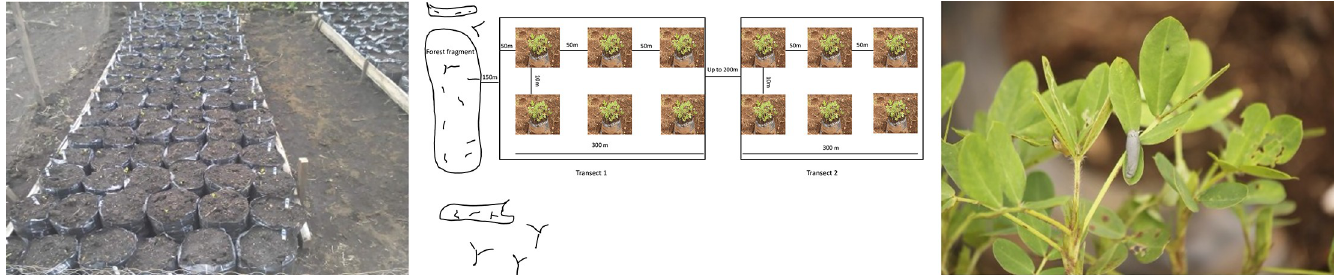
Fig 2. Experimental set-up. (A) seeds of groundnuts and bambara nuts planted into polypots. (B) Experimental set up in farmlands; six crop plants were placed in each transect (i.e., three replications for each crop species). (C) Mimics placed on crop plant. https://doi.org/10.1371/journal.pone.0255638.g002 sections. In total, six crop plants (i.e., three replications for each crop species) were placed in each transect (Fig 2B). To estimate bird predation rates, we used plasticine, a non-toxic putty-like modelling mate- rial (Newplast, UK). We made plasticine mimics of brown and green caterpillars, grey beetles and grey larvae as baits for birds [37, 60, 64, 65]. The colours and shape of the plasticine mim- ics resembled as closely as possible insect species we had found on the crop plants in the fields. We tried three different prey types to maximise the chance that at least one of the mimic types was considered as prey. At the end of the experiment there was found to be no difference in predation rates across mimic type: inclusion of prey type in the models had no significant effect (footnotes to the models in Tables 1 and 2). Caterpillars, beetles and larvae were all made to the same size; diameter 3.5 mm and length 25 mm and as close to the shape of their real-life counterparts as possible. We then attached the mimics to the plant leaves using UHU all-pur- pose adhesive glue (Fig 2C). We randomly placed six mimics on the leaves of each experimen- tal crop plant, one mimic per leaf, amounting to a total of 540 mimics. We note that placing mimics on every plant may not be ideal. For example, birds have a good learning ability so may learn that the mimics are not prey [37, 54, 66]. We monitored the mimics daily for 12 weeks along transect sections (three transects per day) to record bird attack marks and/or the number of missing mimics. At the end of each week, all mimics were collected for identifica- tion of bird predation marks, then remoulded into prey shapes and replaced on the crop plants. Bird attack marks were identified under a magnifying hand lens. Artificial mimics were considered predated if they had a distinct beak mark that looked like a bird attack mark, or they were missing. If an entire pest mimics was removed from the plant, we considered it bird predation, because most vertebrate attacks on artificial caterpillars are by birds [54], and pred- atory arthropods (e.g., wasps and other insects) may be unable to remove an entire mimics Table 1. Model 1A. The relationship between bird attack marks on pest mimics and insect-eating bird abundance, and distance to a forest fragment. The model also tests how the relationship between bird attack marks and bird abundance depends on distance to a forest fragment. Variables Estimate SE t p (Intercept) 3.47 0.29 12.14 < 0.001 Distance − 0.00044 0.00010 − 4.57 < 0.001 Insect-eating bird abundance 0.081 0.013 6.12 < 0.001 Distance � Insect-eating birds − 0.000019 0.000010 − 1.87 0.063 Note . Full model; Bird attack marks = insect-eating birds + distance + insect-eating birds � distance, random = ~1|section, method = "ML". Significant p–values are given in bold. Pest mimic type was not significant when added to this model: Green mimics -0.064 ± 0.17, t = -0.4, P = 0.70; grey mimics -0.066 ± 0.17, t = -0.4, P = 0.70, brown mimics set to the intercept.